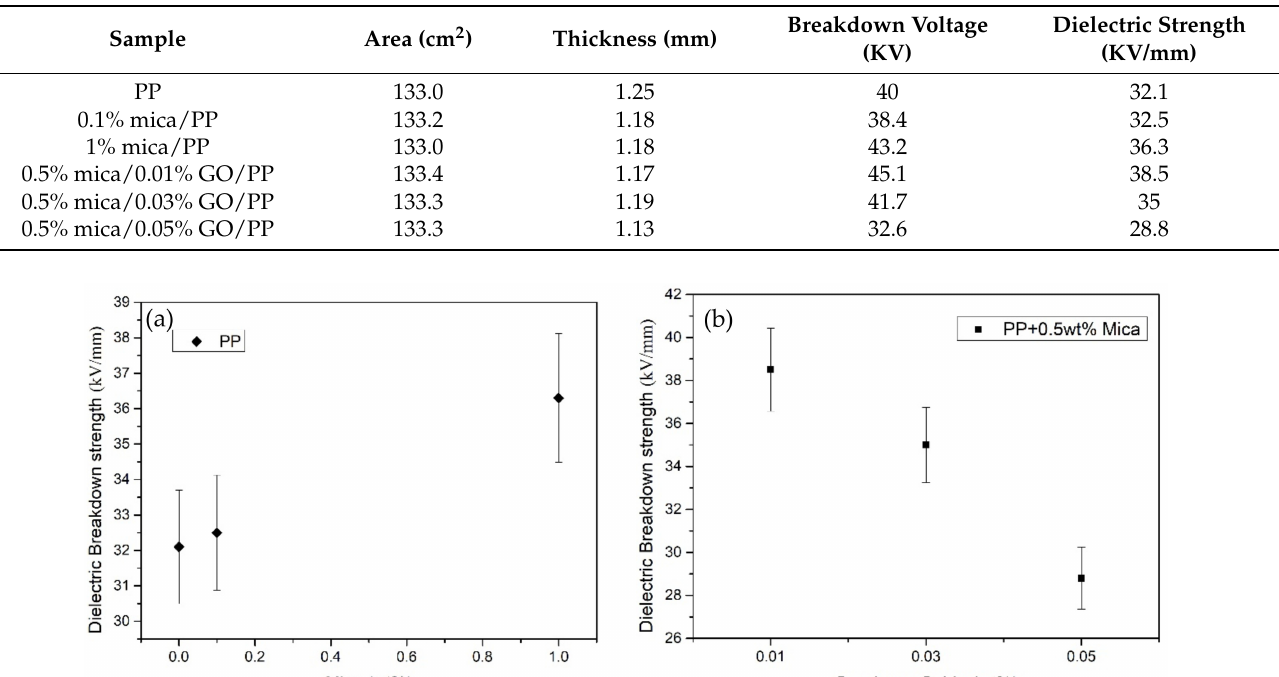
Figure 9. Dielectric strength comparison of all samples ( a ) the PP film with different proportions of mica addition, ( b ) 0.5 wt% mica with varying proportions of graphene oxide added to the